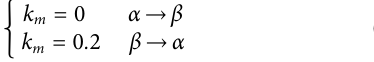
Frontiers in Energy Research |